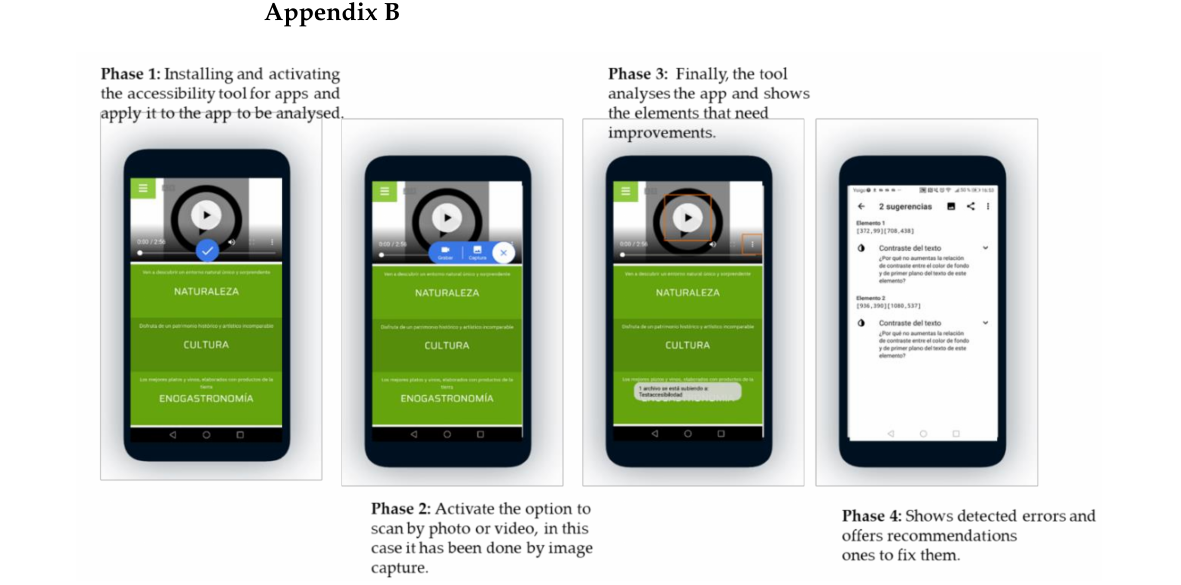
Figure A1. Phases from evaluation of accessibility in mobile applications [41]. Source: own